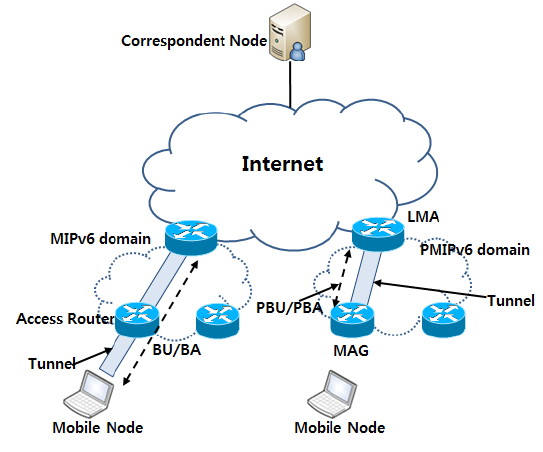
Figure 1. The architectures of MIPv6 and